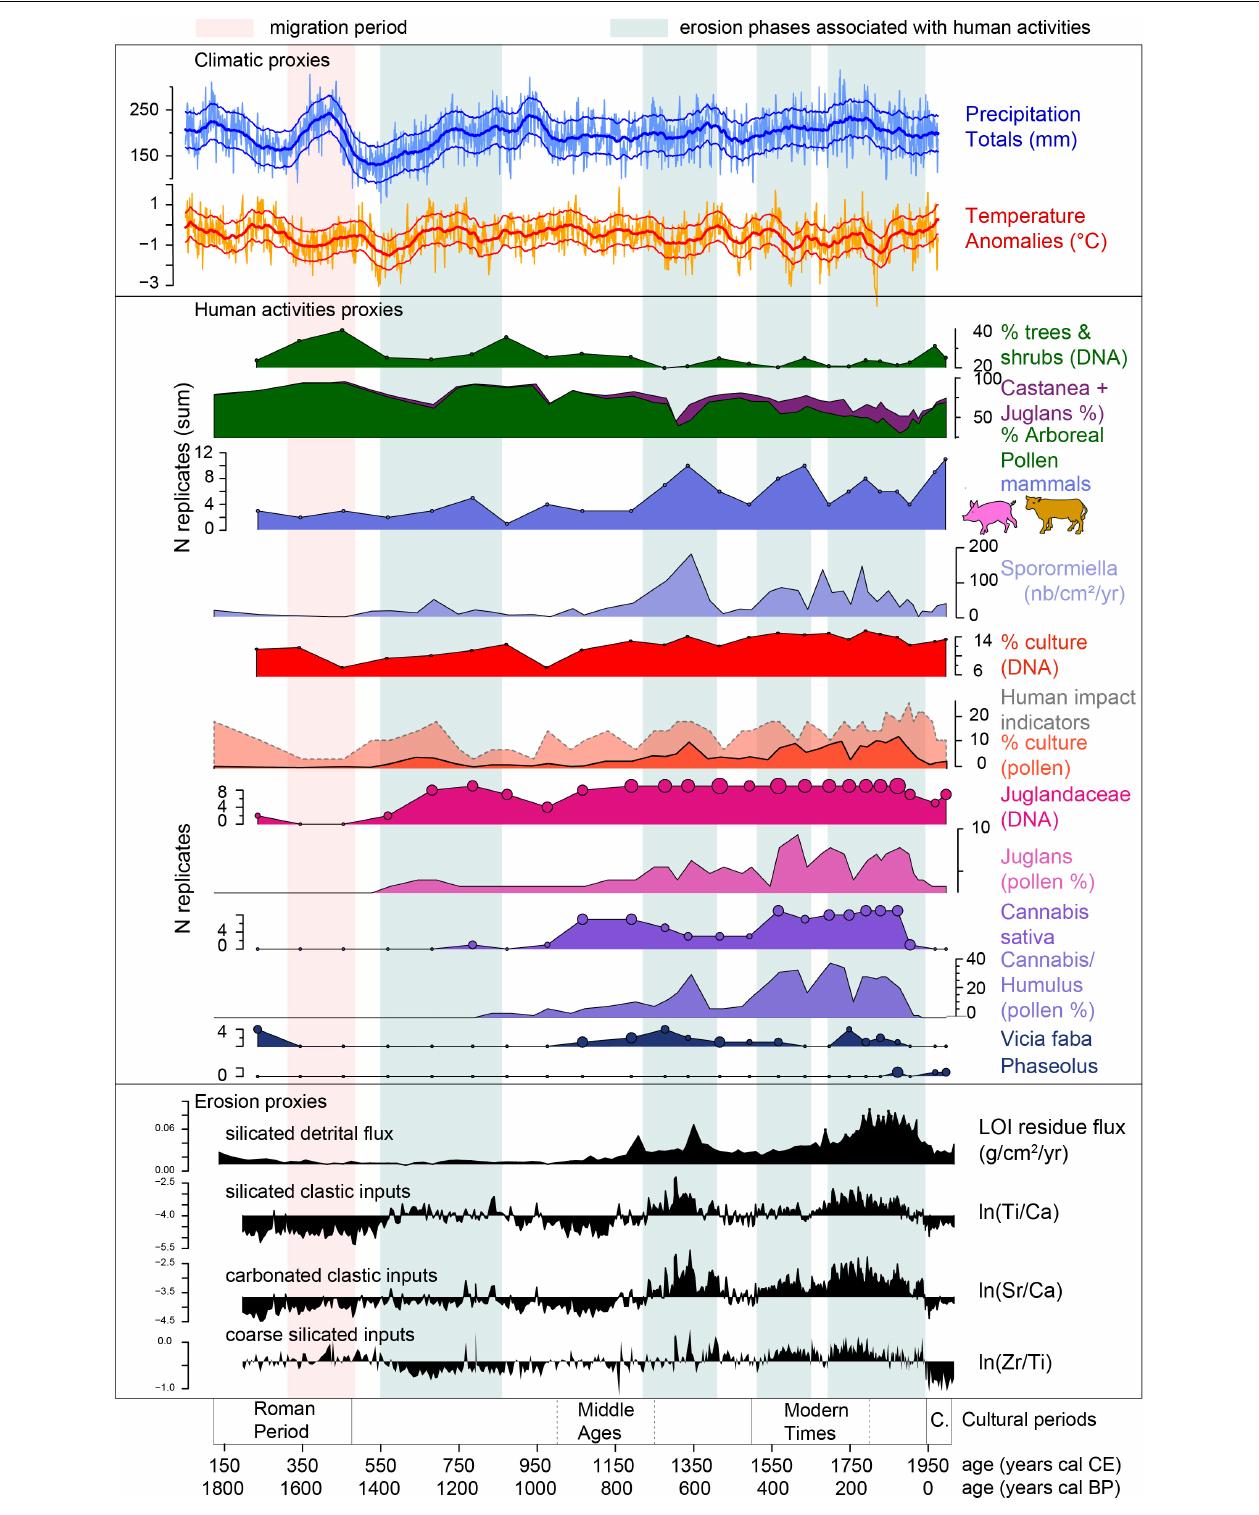
FIGURE 9 | Synthesis of human and environmental histories recorded at Aiguebelette (this study) and regional climatic variations based on tree ring analysis (Büntgen et al., 2011).